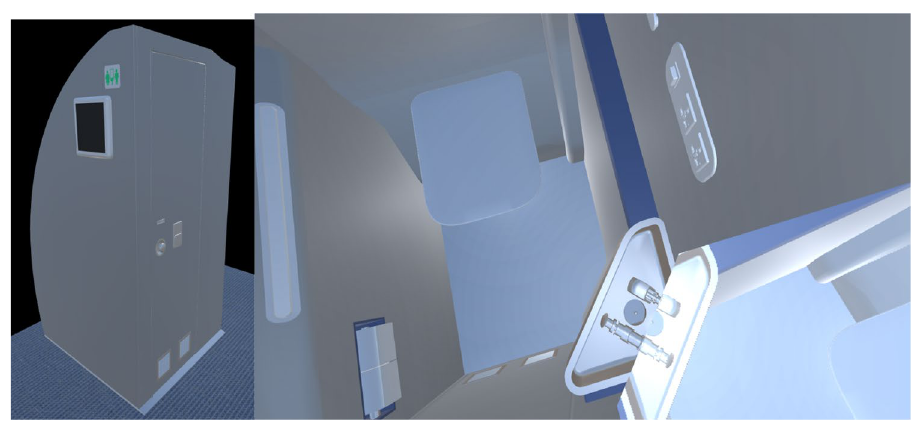
Figure 4. The virtual mock up of the